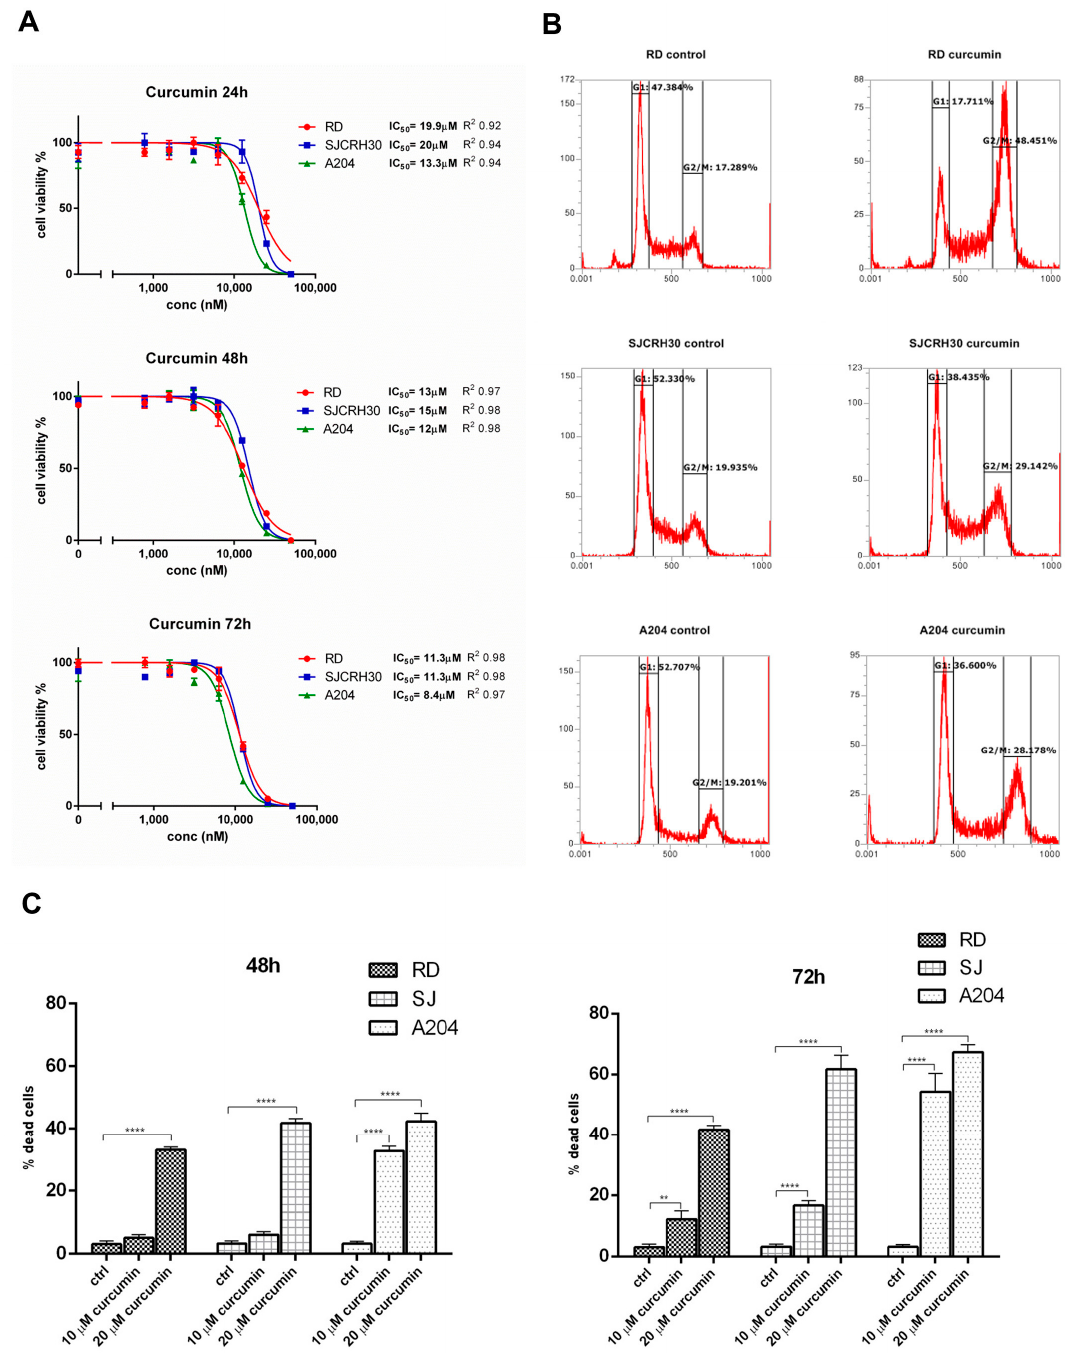
Figure 1. Curcumin treatment leads to decreased cell proliferation/viability and a G2/M cell cycle arrest in RMS cell lines. ( A ) The effects of curcumin on the proliferation and viability of A204, RD, and SJRH30 (RH30) cells was assayed using a resazurin-based cell proliferation/viability assay at 24, 48, and 72 h in the presence of various concentrations of curcumin (0.8–50 µ M). IC50 values were obtained after 48 and 72 h treatment. Three replicates were tested per concentration and at least three independent experiments were performed (bars, ± s.d.). ( B ) Rhabdomyosarcoma cells (A204, RD,